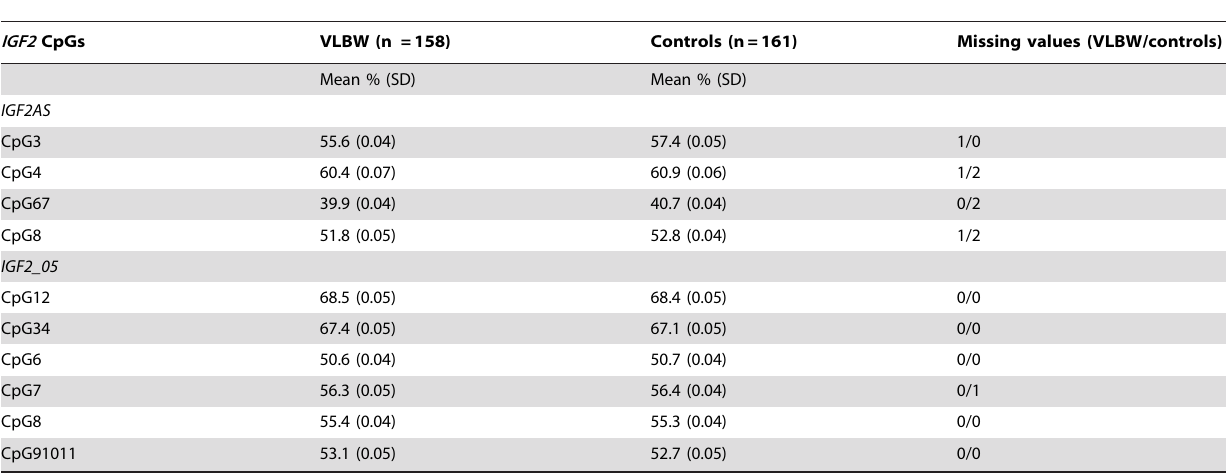
Table 3. Mean (SD) methylation % at different IGF2 CpG units in VLBW and control subjects.